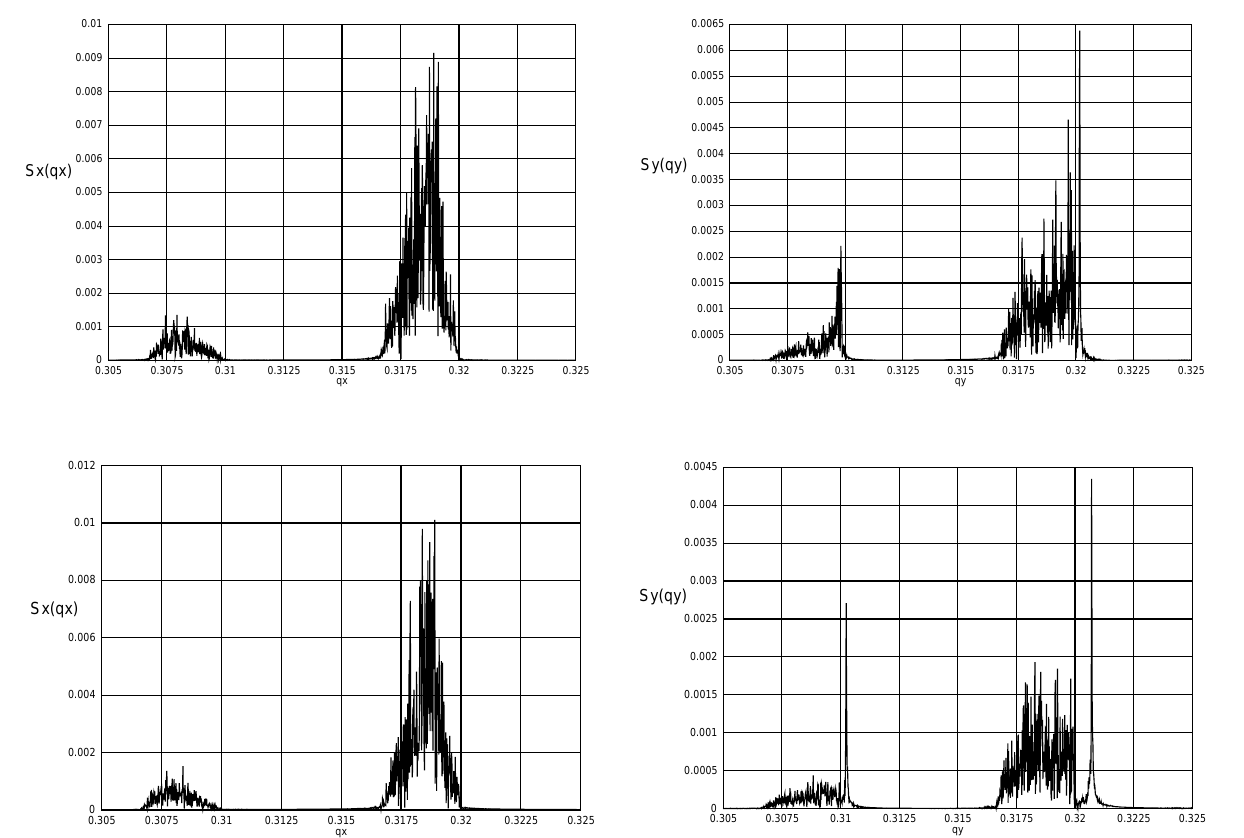
(cid:1) 0.32 and bunch 2 with tune x , y